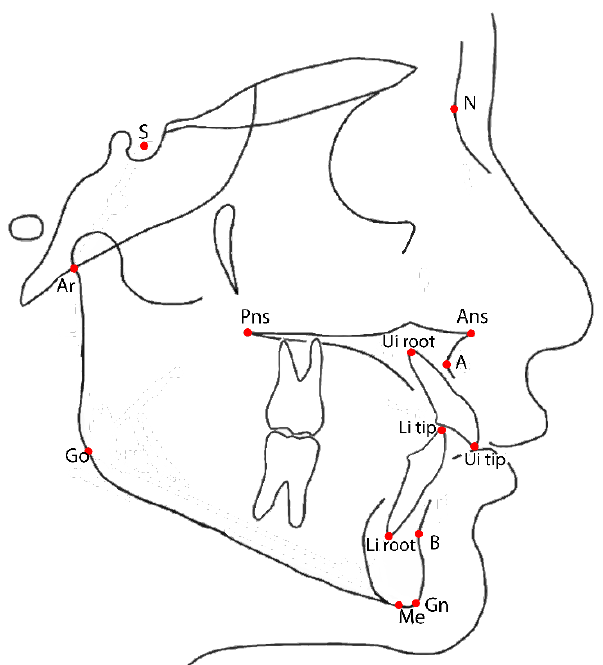
Figure 2. Cephalometric landmarks used in the present study on lateral cephalogram. S = Sella; N = Nasion; Ans = Anterior nasal spine; Pns = Posterior nasal spine; A = Point A (most concave point of anterior maxilla); B = Point B (most concave point of mandibular symphysis); Ui tip = Upper incisor tip; Li = lower incisor tip; Ui root = Upper incisor root; Li root = Inferior incisor root; Gn = Gnathion (midpoint between Pg and Me); Me = Menton (most inferior point of mandibular symphysis); Go = Gonion (the point located at the gonial angle of the mandible); Ar = (junction between inferior surface of the cranial base and the posterior border of the ascending rami of the mandible).